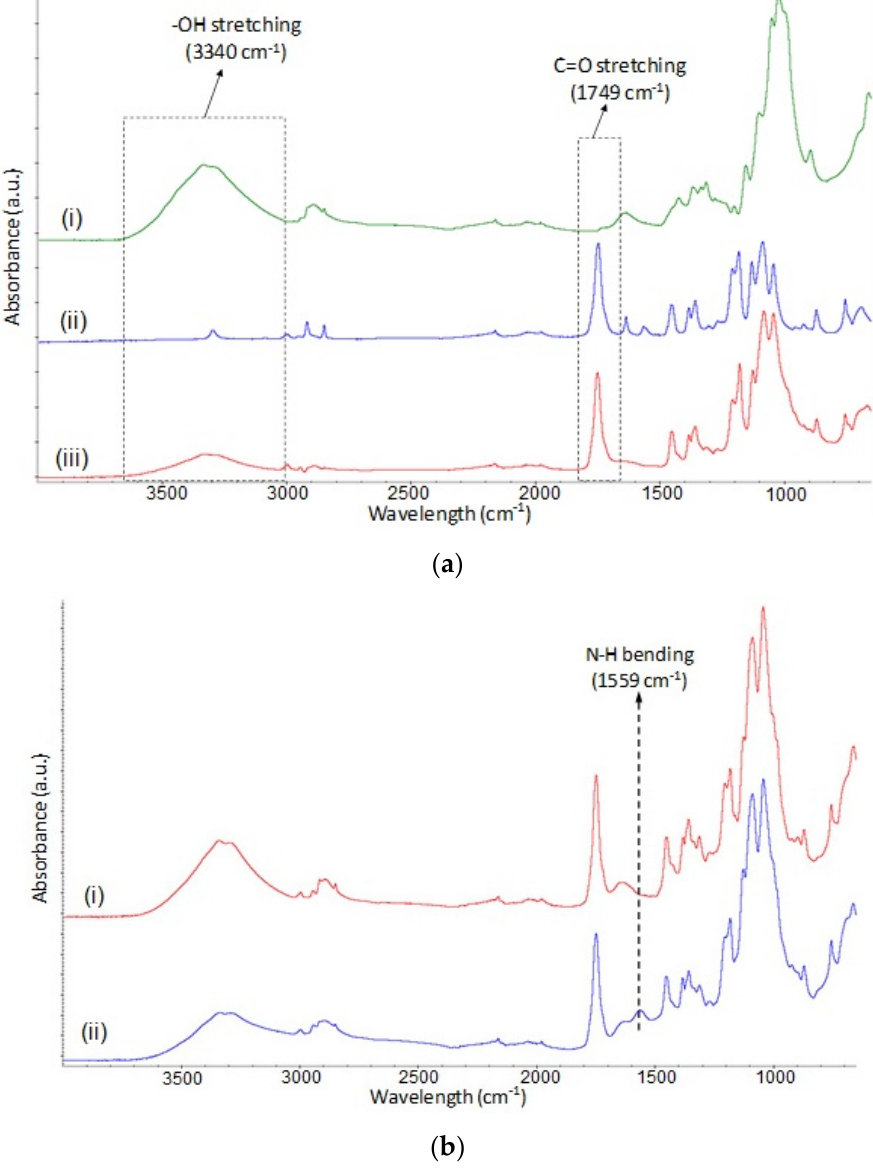
Figure 4. IR spectra of ( a ) (i) flax fibres, (ii) PLA, and (iii) commingled Flax/PLA woven fabric; and ( b ) (i) untreated and (ii): APTES-treated Flax/PLA fabrics (3 wt-% APTES Sol.).